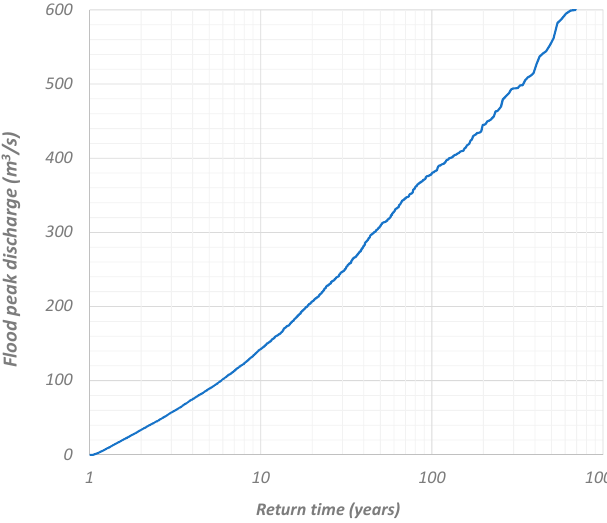
Figure 4. Flood frequency curve for the Mela catchment.